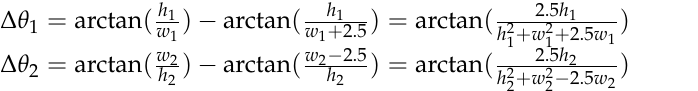
Figure 14. The yaw angle error caused by GNSS single point positioning.